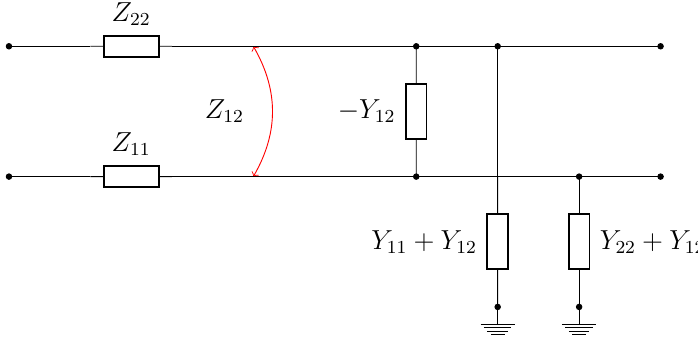
Figure 3. Two-wire Transmission Line (TL) model with Earth